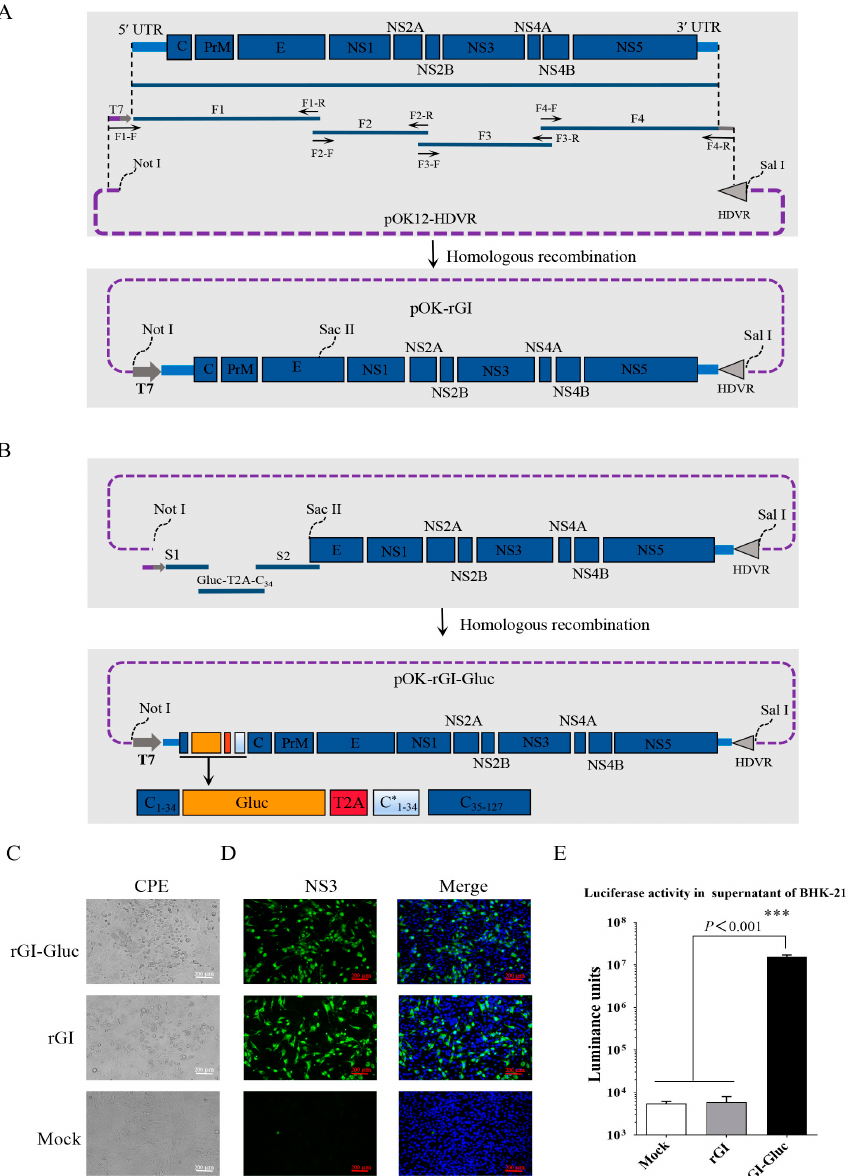
Figure 1. Construction and recovery of Gluc-tagged GI JEV. ( A , B ) Strategy for the construction of the infectious cDNA clone of GI JEV strain YZ-1 and Gluc-tagged GI JEV. T7, T7 promoter. HDVR, hepatitis D virus ribozyme sequence. ( C ) The cytopathic effects in BHK-21 cells transfected with viral RNA at 36 hpi. ( D ) Verification of the rescued JEV by IFA. BHK-21 cells were respectively infected with a parental virus (rGI) and a reporter virus (rGI-Gluc) for 24 h. The expression of JEV NS3 protein was detected with an antibody against NS3 (green), and cell nuclei were stained with DAPI (blue). ( E ) Luciferase activity in culture supernatants. The supernatants of BHK-21 cells mock-infected or infected with viruses were respectively harvested and analyzed by luciferase assay. All data are presented as mean ± SD from three independent experiments and tested by Student’s t -test. ***, p <